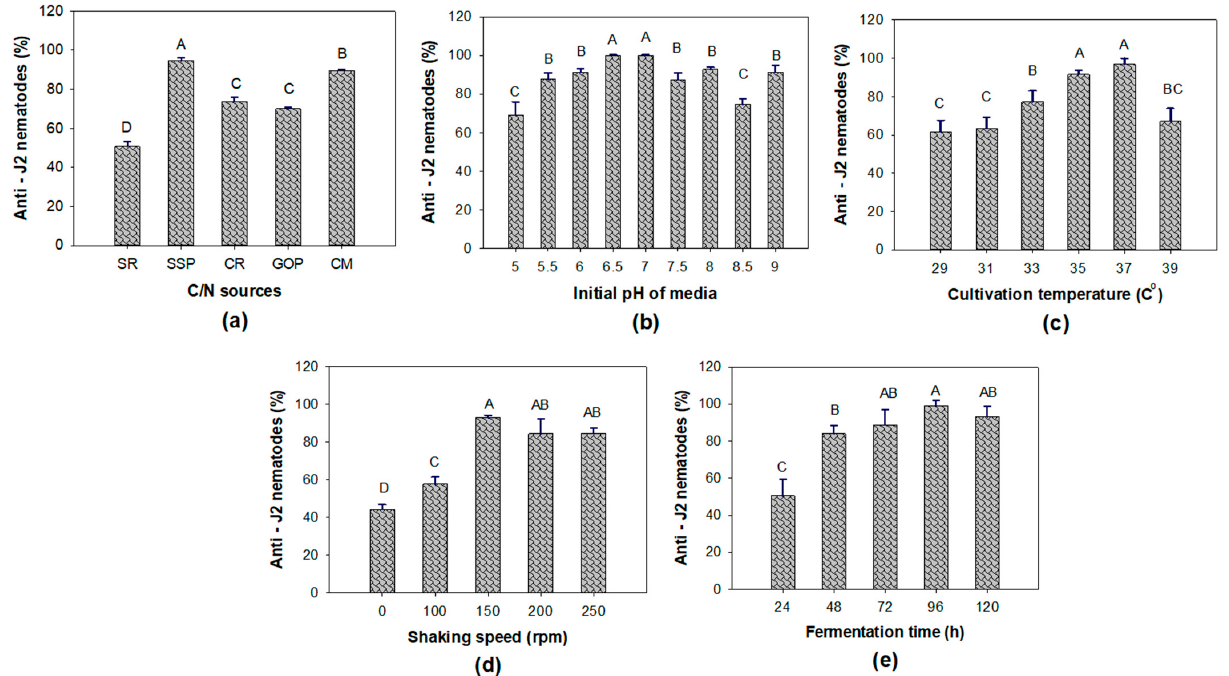
Figure 1. The production of antinematode compounds. The effect of C/N sources ( a ), the initial pH ( b ), cultivation temperature ( c ), shaking speed ( d ), and cultivation time ( e ) on the antinematode activity of supernatants produced by B. veleznesis RB.EK7 were examined. Values in the same figure with the different letters (A–D) are significantly different.